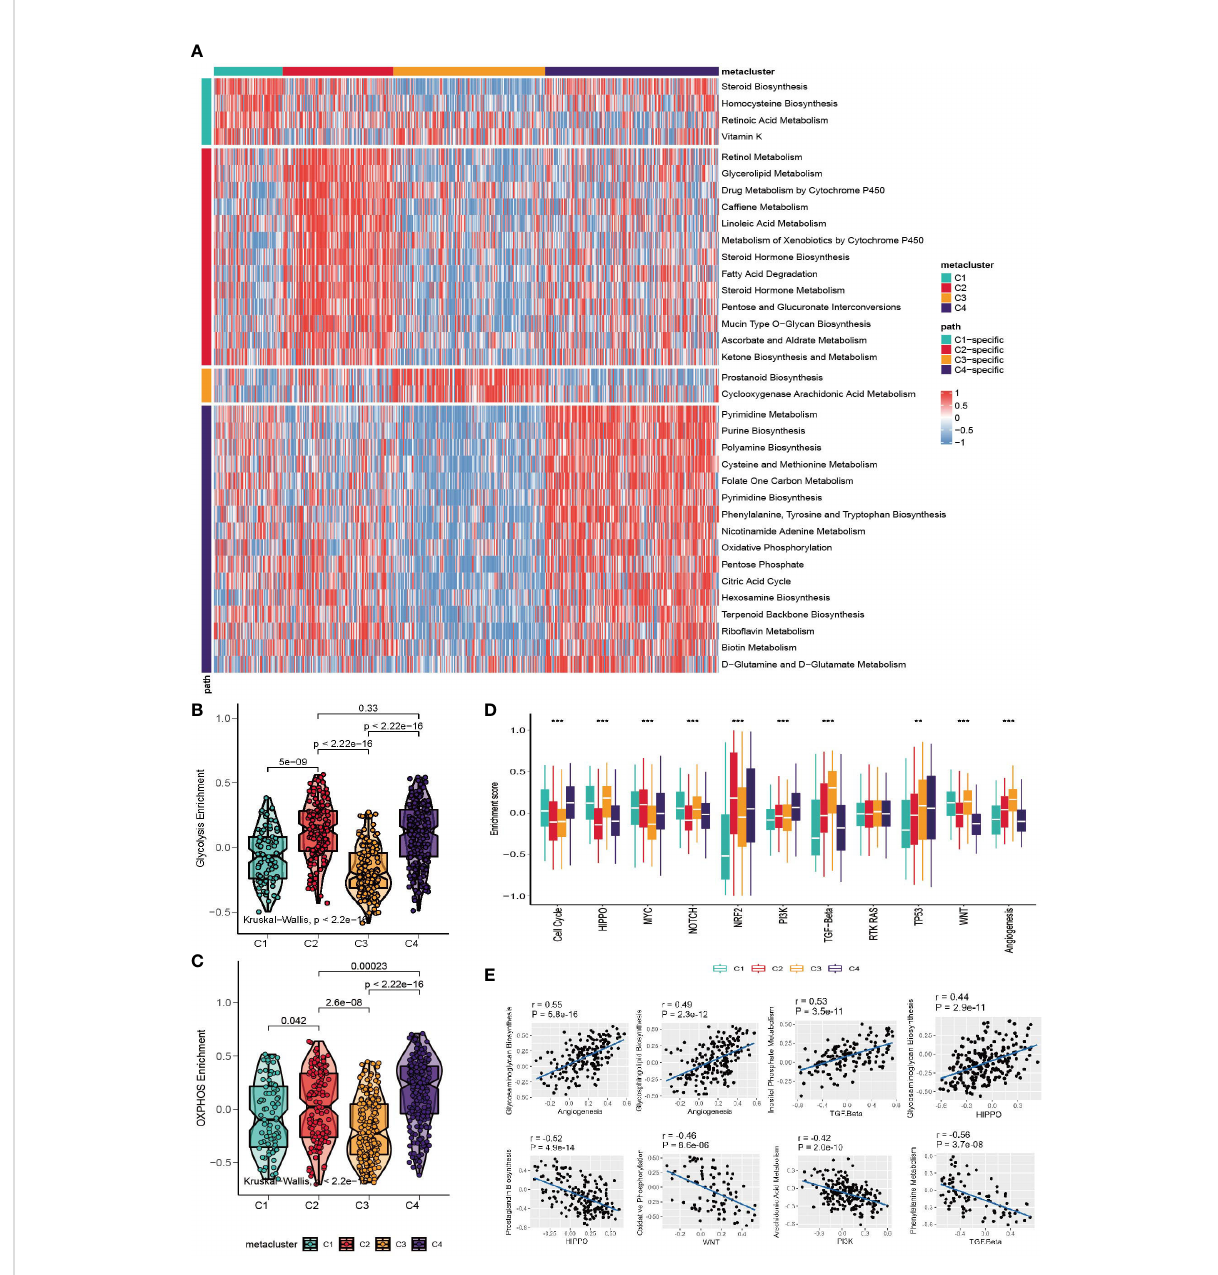
FIGURE 2 Association between metabolism signature and GC subclasses. (A) Heatmap of subclass-speci fi c metabolism signatures. (B, C) Comparison of glycolysis and OXPHOS level among C1-C4. (D) Enrichment of oncogenic pathway signatures among C1-C4 (*p < 0.05; **p < 0.01; ***p < 0.001). (E) Pearson correlation between oncogenic pathways and metabolism